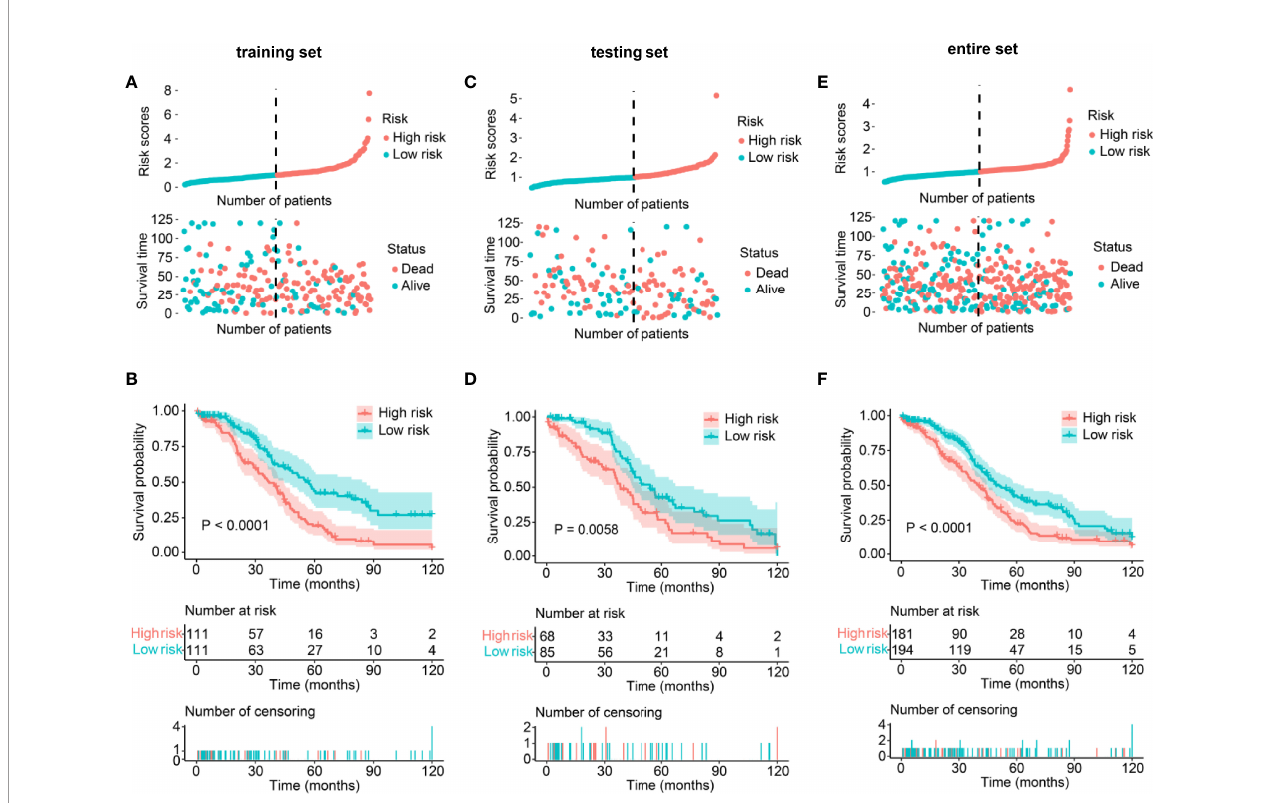
FIGURE 2 | Validation of the lncRNA-based prognostic risk model in the training set, testing set, and entire set. (A, C, E) Distribution of risk score and survival status between low/high-risk SOC patients in the training set (A) , testing set (C) , and entire set (E) . The blue color represents patients with a low risk score, and the red color represents patients with a high risk score. Distribution of risk score based on the writer-related lncRNA model (Upper panel). Survival status and survival time between the high- and low-risk subgroups (Lower panel). (B, D, F) Kaplan – Meier survival analysis between low- and high-risk subgroups of patients in the training set (B) , testing set (D) , and entire set (F)